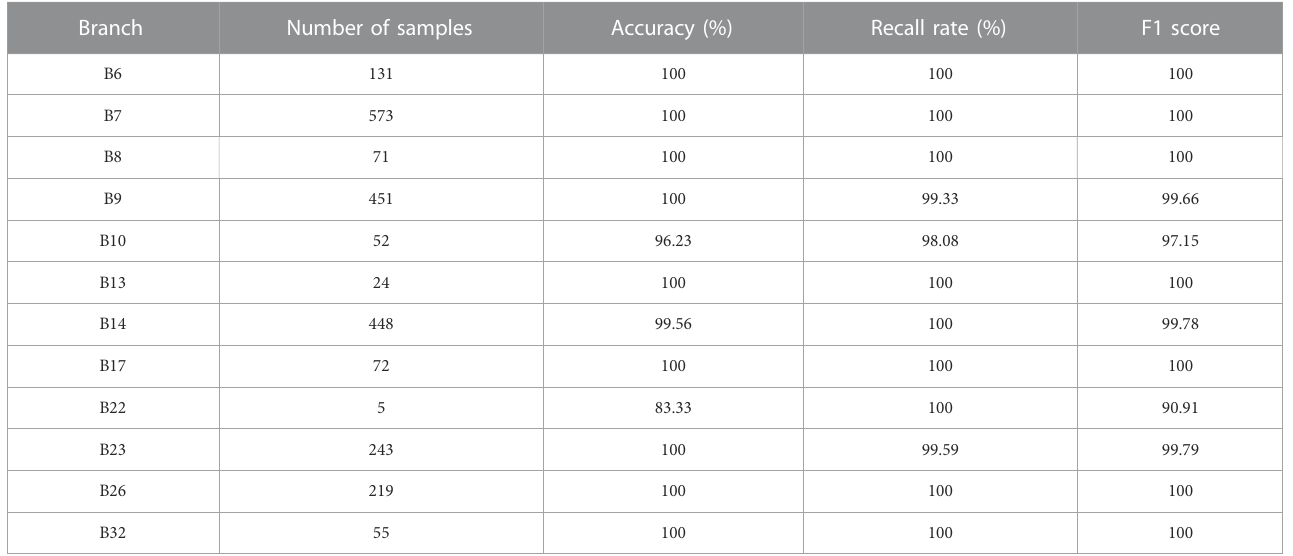
TABLE 4 Classi fi cation index of main action